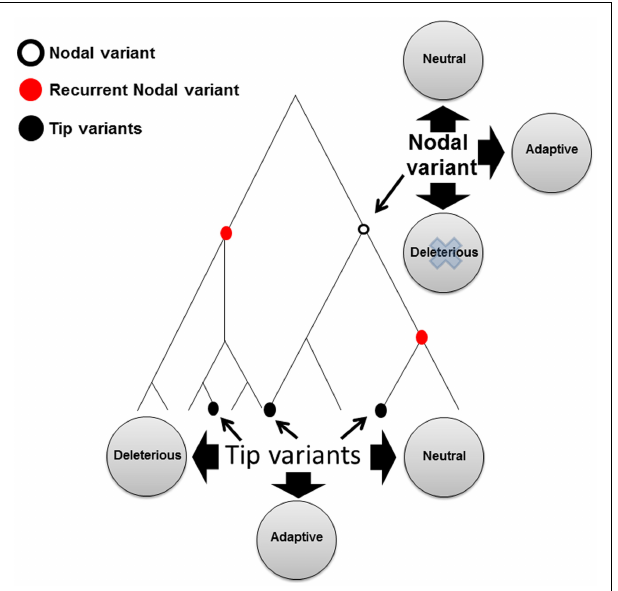
FIGURE 2 |A schematic phylogenetic tree illustrating tip, nodal, and recurrent nodal variants. Tip variants, black filled circle; Nodal variant, black empty circle; RNM, red